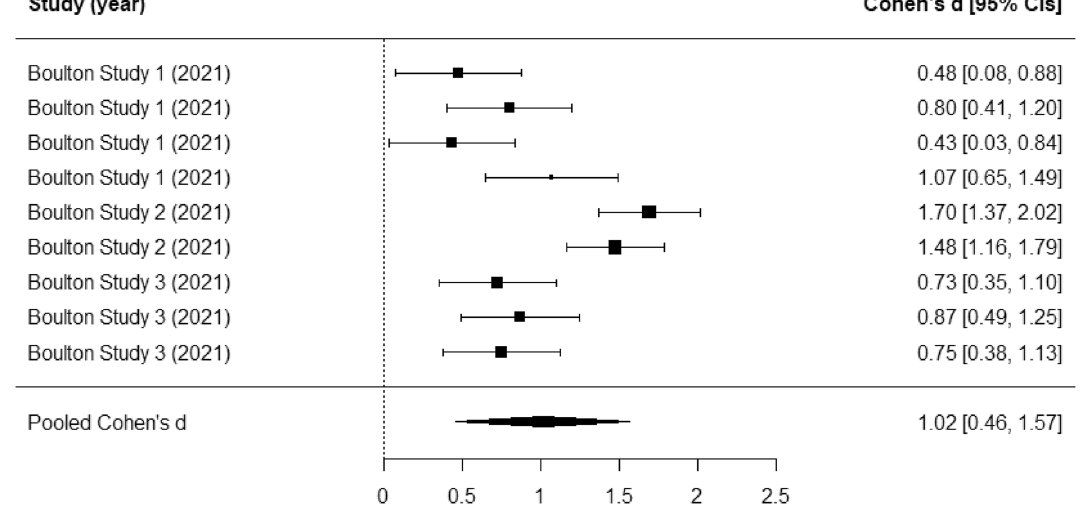
Figure 3. Forest plot for attitudes toward bullying.